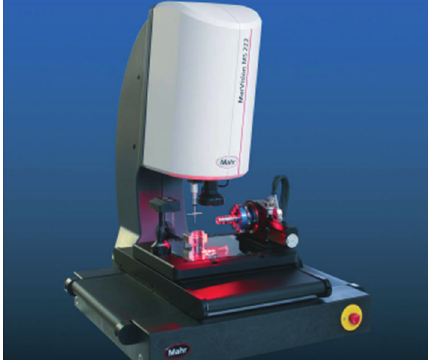
Figure 3: MarVision MS 222 (informational